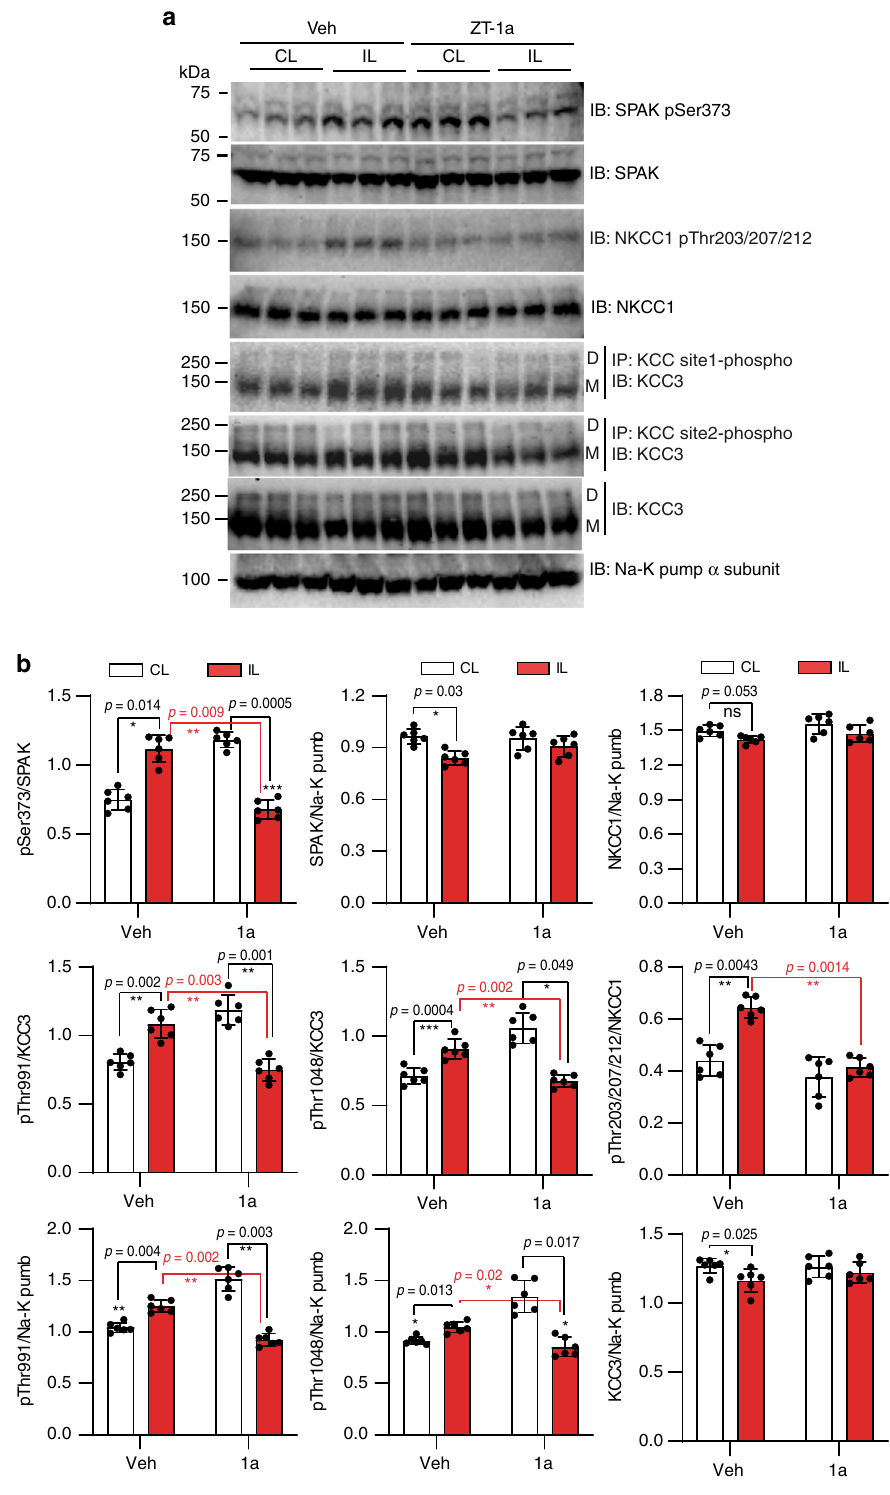
Fig. 8 ZT-1a decreases ischemia-induced SPAK – CCC phosphorylation. a Representative immunoblots (IB) of phospho-SPAK/OSR1 (pSPAK/pOSR1), phospho-KCC3 (pKCC3), and phospho-NKCC1 (pNKCC1) in mouse brains studied 24 h post reperfusion after ischemic stroke. Membrane protein fractions were prepared from contralateral (CL) and ipsilateral (IL) cerebral hemispheres. Vehicle (Veh, DMSO) or ZT-1a (5 mg/kg) were administered as described in Fig. 7a. Na + – K + ATPase α -subunit served as loading control for membrane protein fraction. b Densitometry analyses of immunoblots (similar to those in panel a ) of pSPAK/pOSR1, pKCC3, pNKCC1, tSPAK/tOSR1, and tNKCC1 in mouse brains studied 24 h of reperfusion after tMCAO. Data are means ± SEM, n = 6 per group (male 3, female 3). *** p < 0.001; ** p < 0.01; * p < 0.05 versus control, one-way